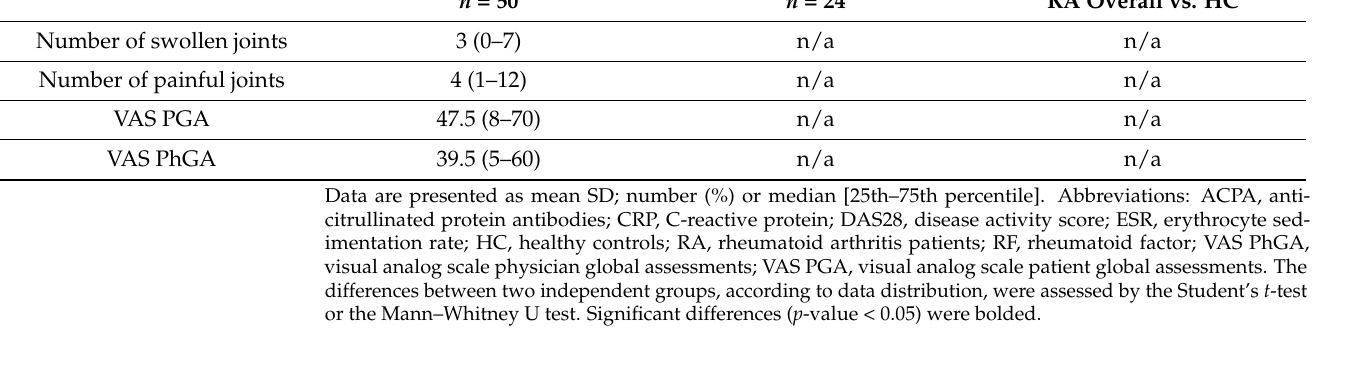
Table 2. Characteristics of the patients with rheumatoid